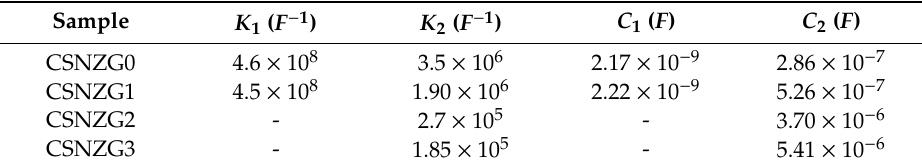
Table 3. The EEC fitting parameters for the plasticized systems at room